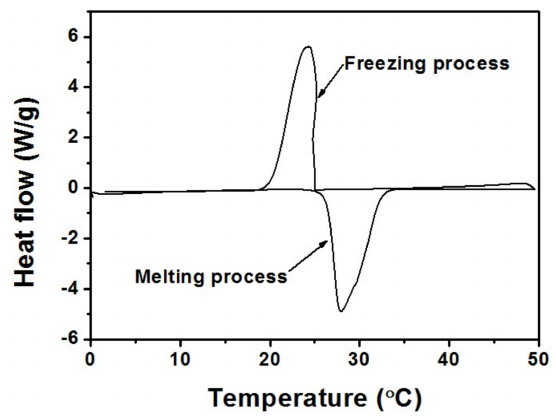
Figure 5. The differential scanning calorimeter (DSC) curve of n